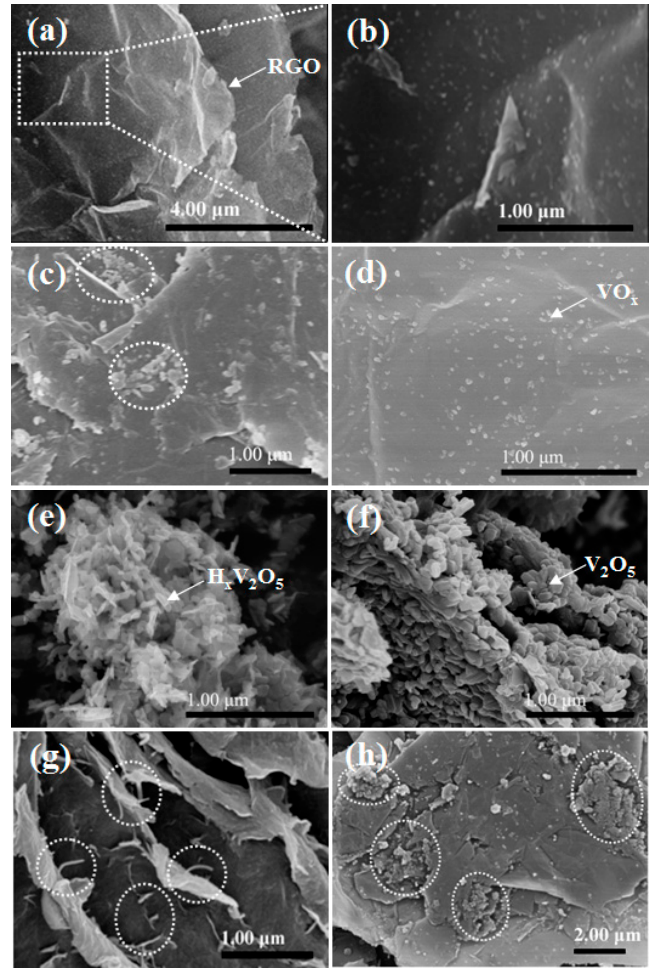
Figure 2. Scanning electron microscope (SEM) images of the VG ‐ as ( a and b ); VG ‐ A300 ( c ); VG ‐ N ‐ A300 ( d ); VG ‐ N ‐ A350 ( e ); VG ‐ N ‐ A400 ( f ); VO x /RGO reference sample obtained in H 2 O solution ( g ); VG-N-A300 ( d ); VG-N-A350 ( e ); VG-N-A400 ( f ); VO